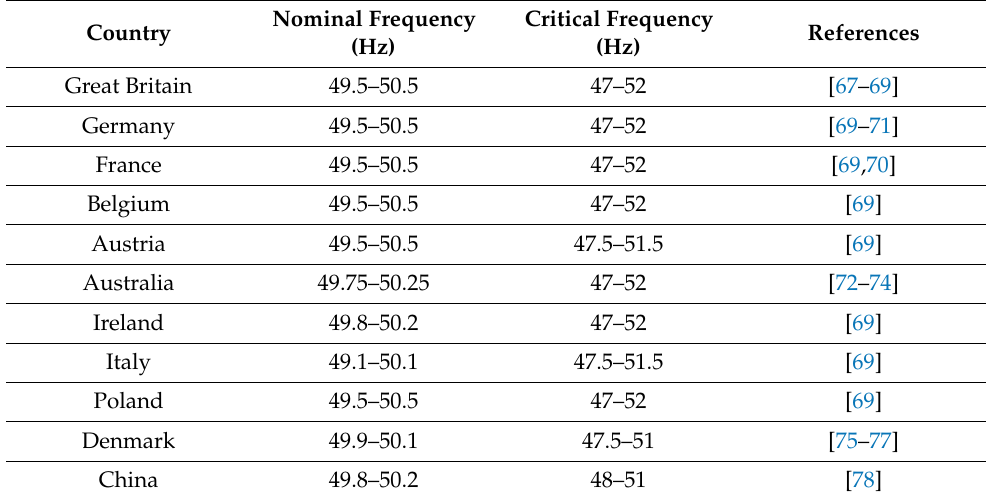
Table 1. Nominal and critical frequency intervals in the power systems of different